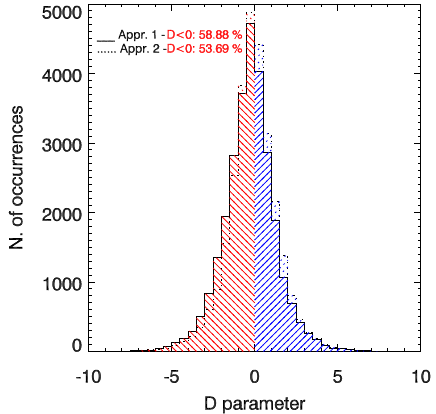
Fig. 9. Histogram of the parameter D (see Eq. 3) for all pixels over Europe for the day 20 August 2009, 09:00UTC, for the surface- 6km ozone partial